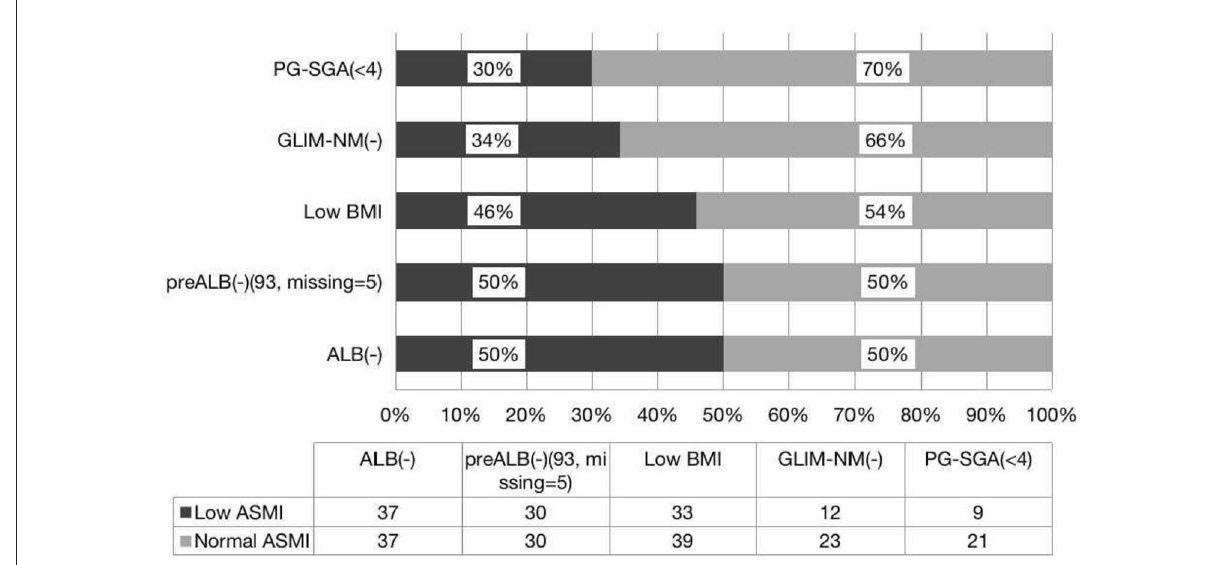
FIGURE1 Consistence of the ASMI with the nutritional scales/parameters in the nutritional assessment of patients with HSCT.